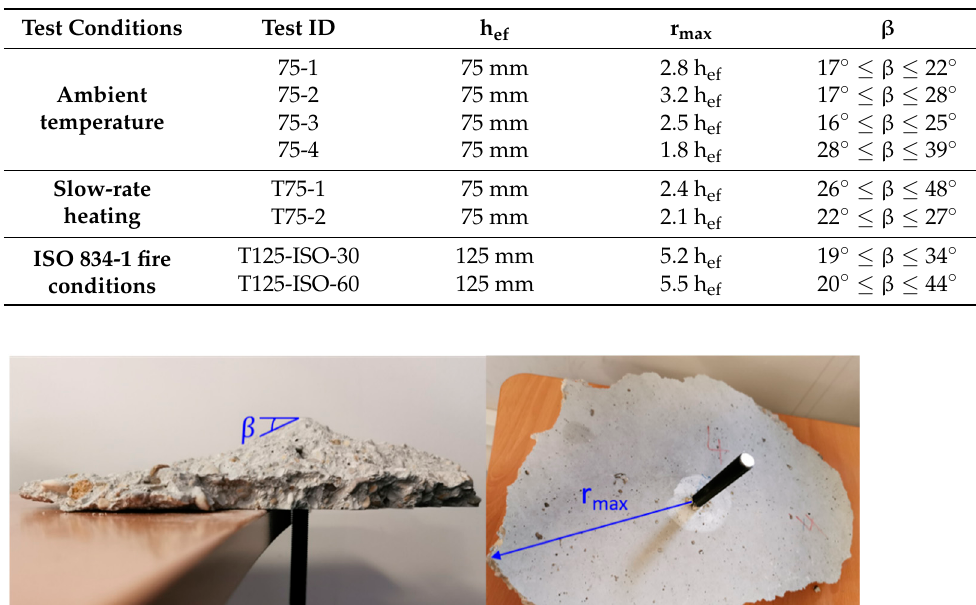
Table 3. Geometrical characteristics of the concrete cones.